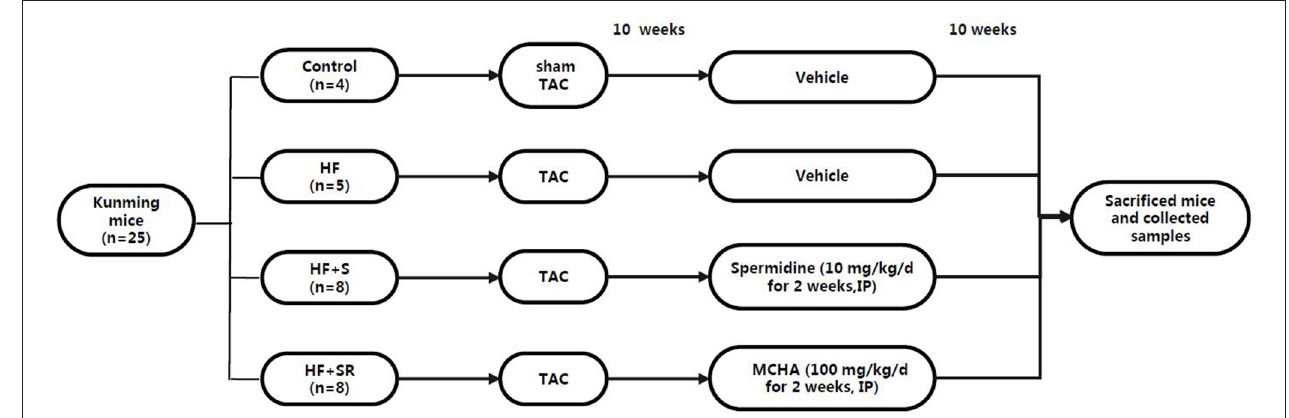
FIGURE 1 | The animal grouping and time line of the experimental